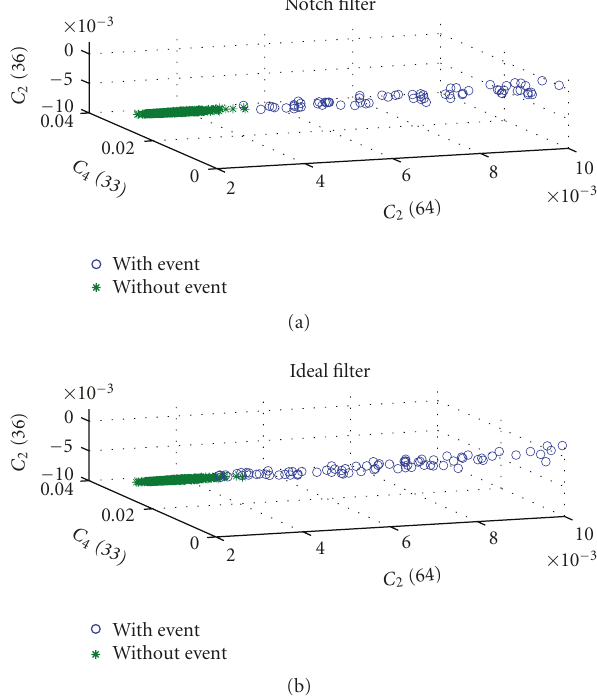
Figure 7: HOS-based features extracted from voltage signals whose frame length is equal to N = 16. While second-order statistics are extracted from f , the fourth-order statistic is extracted from u